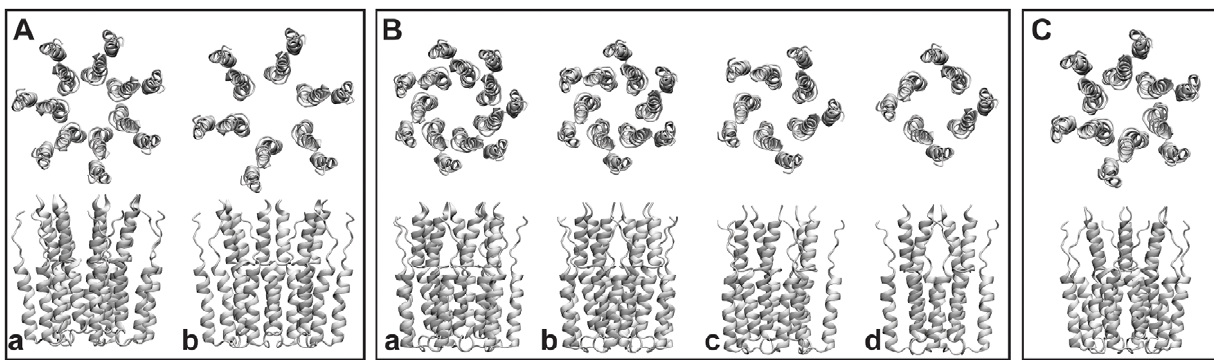
Figure 1. Oligomeric p7 models constructed from the NMR p7 monomer [ 16 ] , using symmetry operations. Box A: (a) Heptamer A, (b) Hexamer A; Box B: (a) Heptamer B, (b) Hexamer B, (c) pentamer, (d) tetramer; Box C: Hexamer C. The models in box A were constructed so that the monomers extend radially away from the center, similar to the model presented earlier [47]. In contrast, the models in box B were built such that the monomers optimize the contacts between their mutual surfaces, consistent with the models described in two prior studies [17,22]. The model in box C was built to be similar to, but have the opposite handedness of Hexamer B.